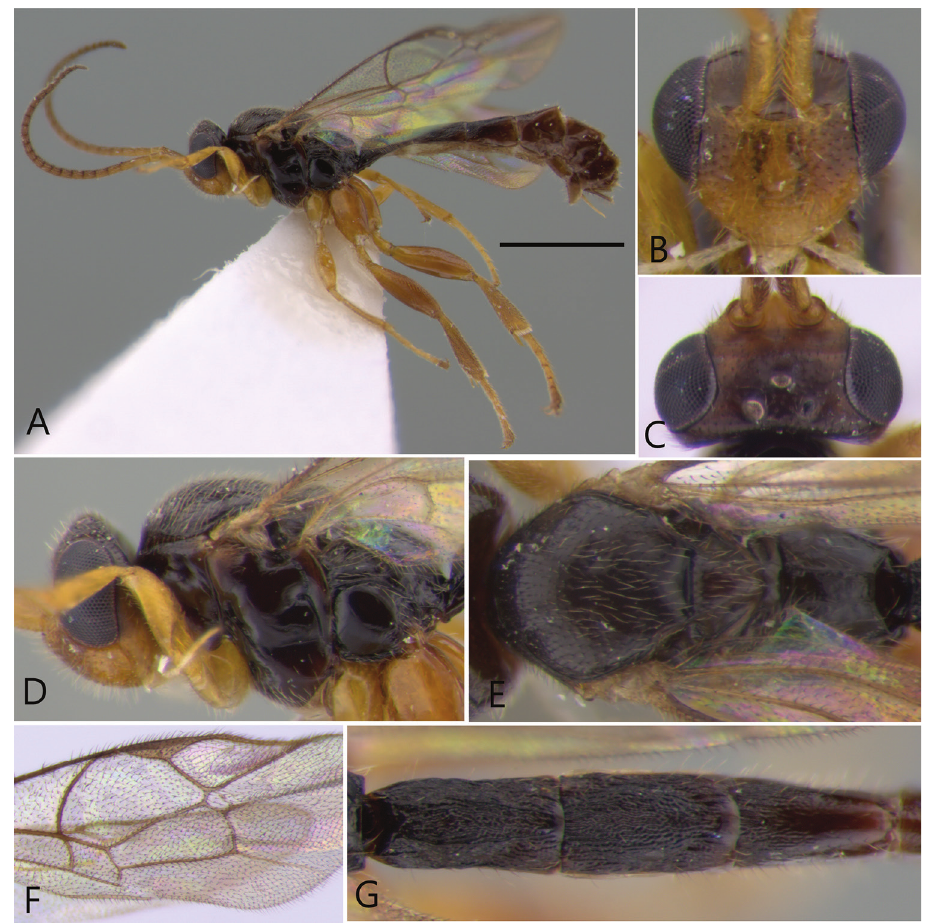
Figure 10. Orthocentrus orientalis sp. nov. Holotype. A Habitus in lateral view B head in frontal view C head in dorsal view D head and mesosoma in lateral view E mesosoma in dorsal view F areolet G first to third tergites in dorsal